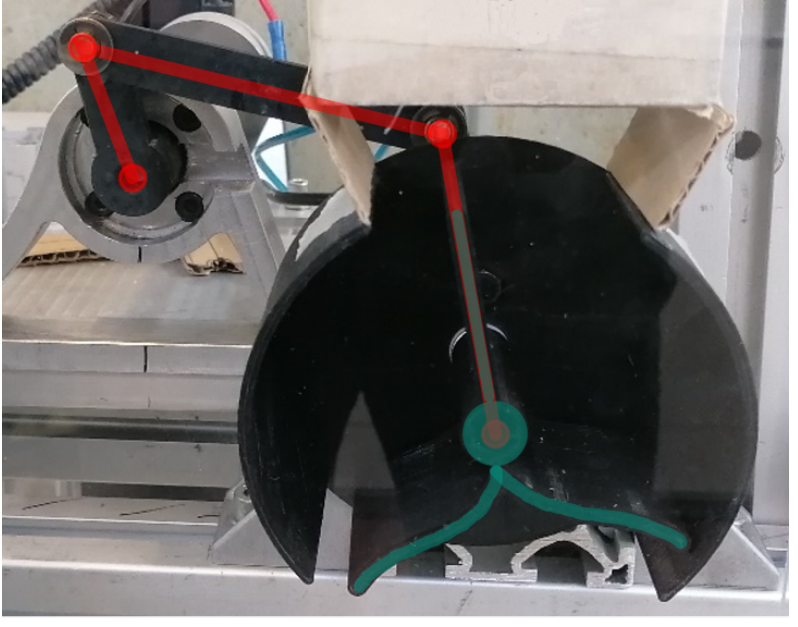
Figure 11. Experimental setup. The four-bar linkage mechanism is highlighted in red, while the blades are highlighted in